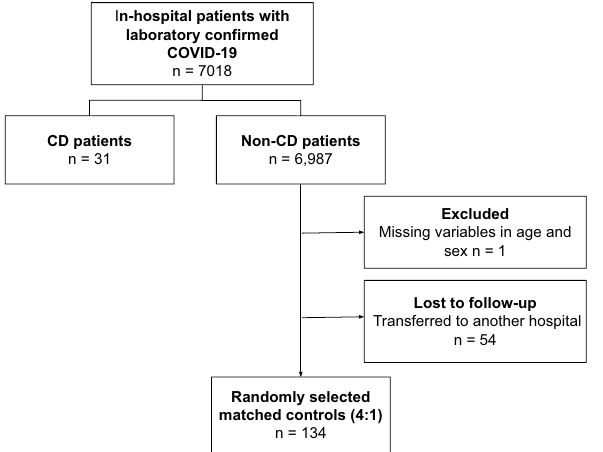
Figure 1. Flowchart of COVID-19 patients included in the